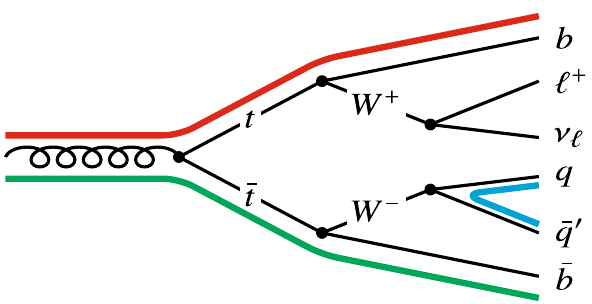
Fig. 2 Illustration of a semileptonic t ¯ t event with typical colour con- nections (thick coloured lines)